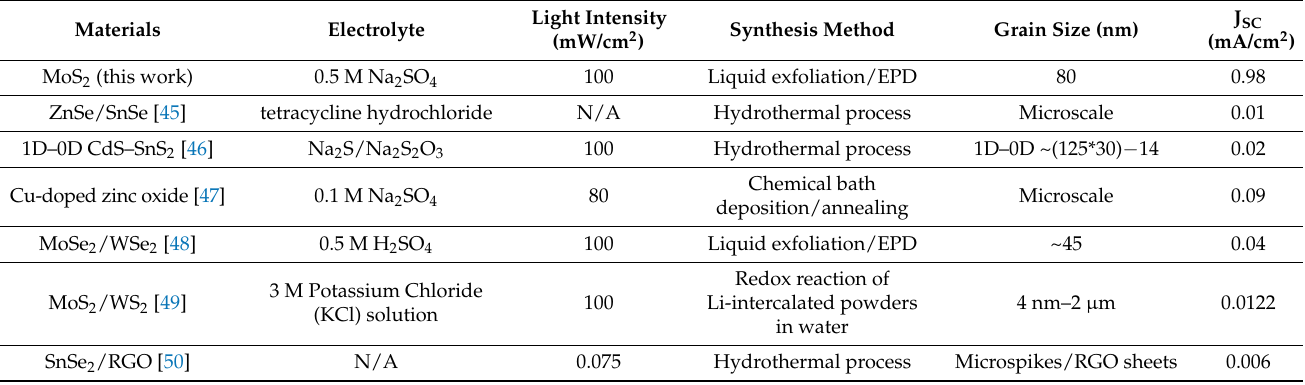
Table 1. Comparison of PET/ITO/MoS 2 with previous literature for hydrogen generation